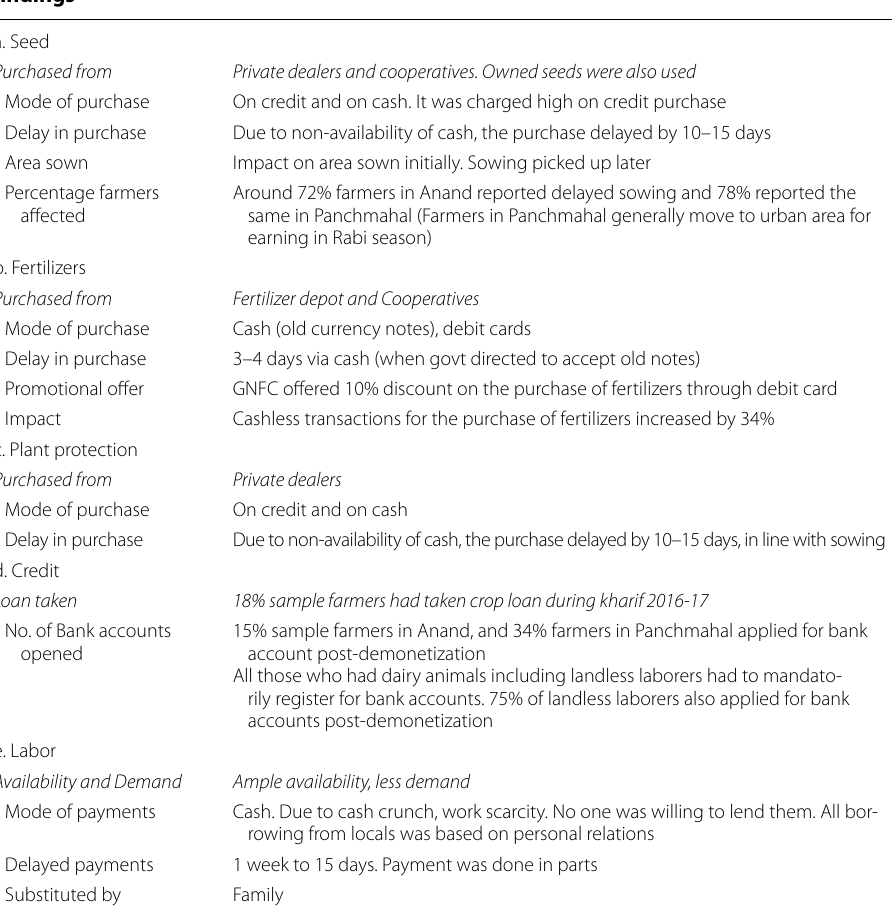
Table 3 Effect of demonetization on input supply sub-system. Source: Primary Survey